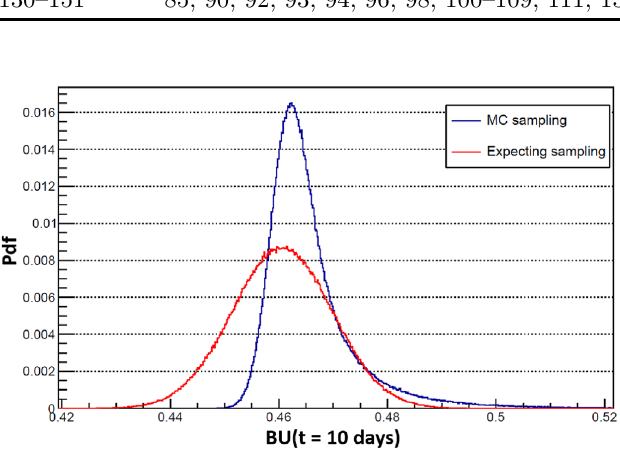
Fig. 3. The probability density function of the MC sampling for the value of the BU at t = 10 days for Exp.2, in blue, compared to the expected Gaussian, in